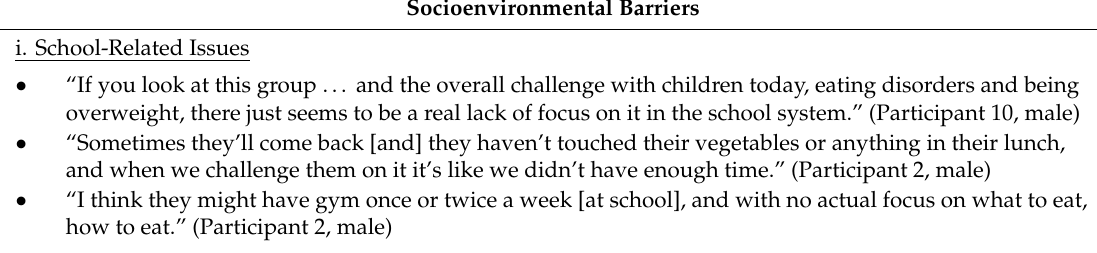
Table 5. Selected quotes related to parents’ perceptions of barriers to health behaviour